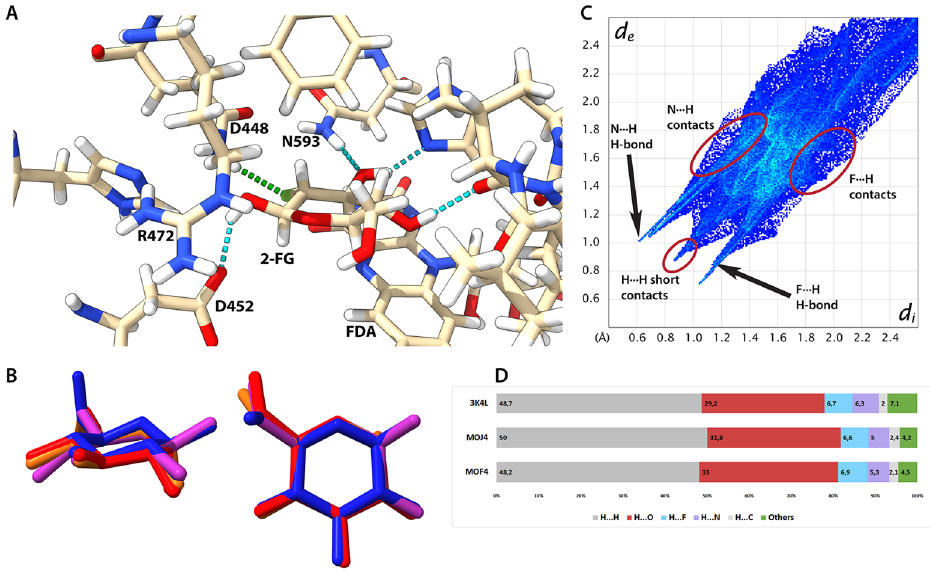
Figure 7. Interactions between 2-FG and selected mutants of P2Ox. ( A ) Structure of catalytic centre of 3K4L structure (some residues have been removed for the sake of ligand visibility). Canonical H-bonds are depicted as dotted cyan lines and F-H bond is depicted as a green dotted line. Residues having a substantial contribution (both negative and positive) to binding are labelled. ( B ) Superimposed structures of 2-FG from 3K4L (magenta), MOJ4 (red), and MOF4 (orange) compared to the structure from the crystalline state (blue). ( C ) Fingerprint plot for the complexed 2-FG in 3K4L structure. ( D ) Contribution of different X ··· X contacts for 2-FG protein complexes derived from their Hirshfeld